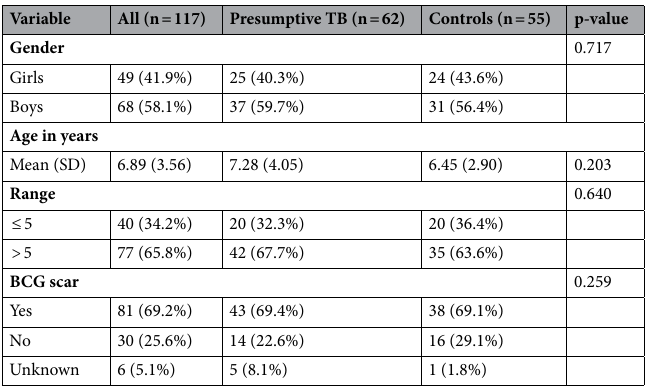
Performance of the TB metabolic fingerprinting. The metabolic fingerprint of the urine samples (n = 117) were measured using both high-field (HF) and LF 1H NMR spectroscopy, as detailed in Fig. 1. Repre- sentative spectra obtained with the HF and LF 1H NMRs are shown in Supplementary Fig. 1. An unsupervised principal component analysis (PCA) 13 was applied to the HF 1H NMR urine spectra of the six bacteriologically confirmed, 52 unconfirmed and four unlikely TB, and the 55 controls not showing clustering patterns between samples. Two children’s samples (one bacteriologically confirmed TB and one control) were considered outliers in the PCA score plot and were excluded 14 (Supplementary Fig. 2). A supervised partial least squares discriminant analysis (PLS-DA) was applied to identify a discriminatory metabolic pattern between presumptive TB and control groups to the remaining 115 urine samples. We observed groupings along the scores of the first component of the PLS-DA (PLS-DA component 1) (Fig. 2). The robustness parameters of the HF PLS-DA model were tested by Leave-One-Out Cross-Validation (LOOCV) using the PLS-DA component 1 showing a performance accuracy to discriminate between presumptive TB and controls of 0.68, with R2 and Q2 values of 0.61 and 0.13, respectively; and an Area Under the Curve of Receiver Operating Characteristic (AUC-ROC) of 0.65. The Variable Importance in Projection (VIP) scores for the PLS-DA component 1 identified the main spectral regions of the metabolic fingerprint to differentiate between children with presumptive TB and controls (Supplementary Table 1). There was a trend in the PLS-DA component 1 scores with the certainty of TB diagnosis (Fig. 2). Thus, children with bacteriologically confirmed (n = 5) and unconfirmed TB (n = 52) had higher median PLS-DA component 1 scores (883.3 ± 751.1 and 913.3 ± 716.6) than children with unlikely TB (n = 4; − 385.2 ± 417.3) (p = 0.026 and p = 0.005, respectively; Fig. 3a). The PLS-DA component 1 scores also varied with the number of clinical criteria for TB. Children with five (n = 7), four (n = 21), and three (n = 27)